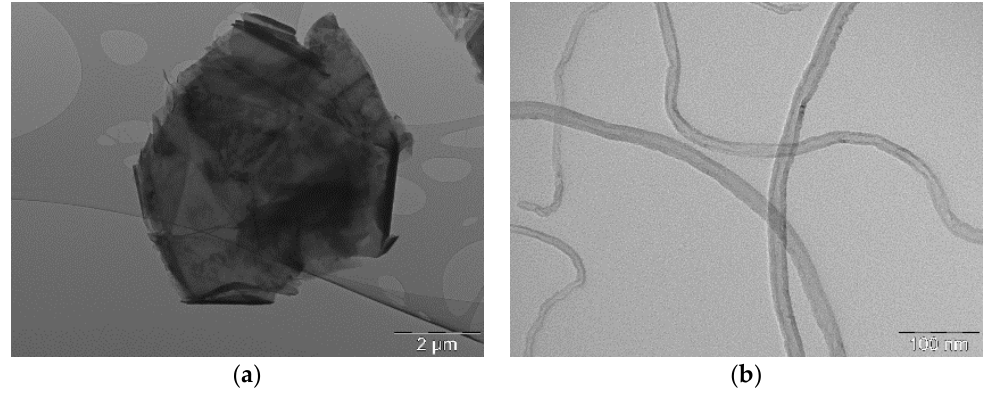
Figure 1. TEM micrographs of the selected carbonaceous nanoparticles: ( a ) GNP and ( b ) CNT.